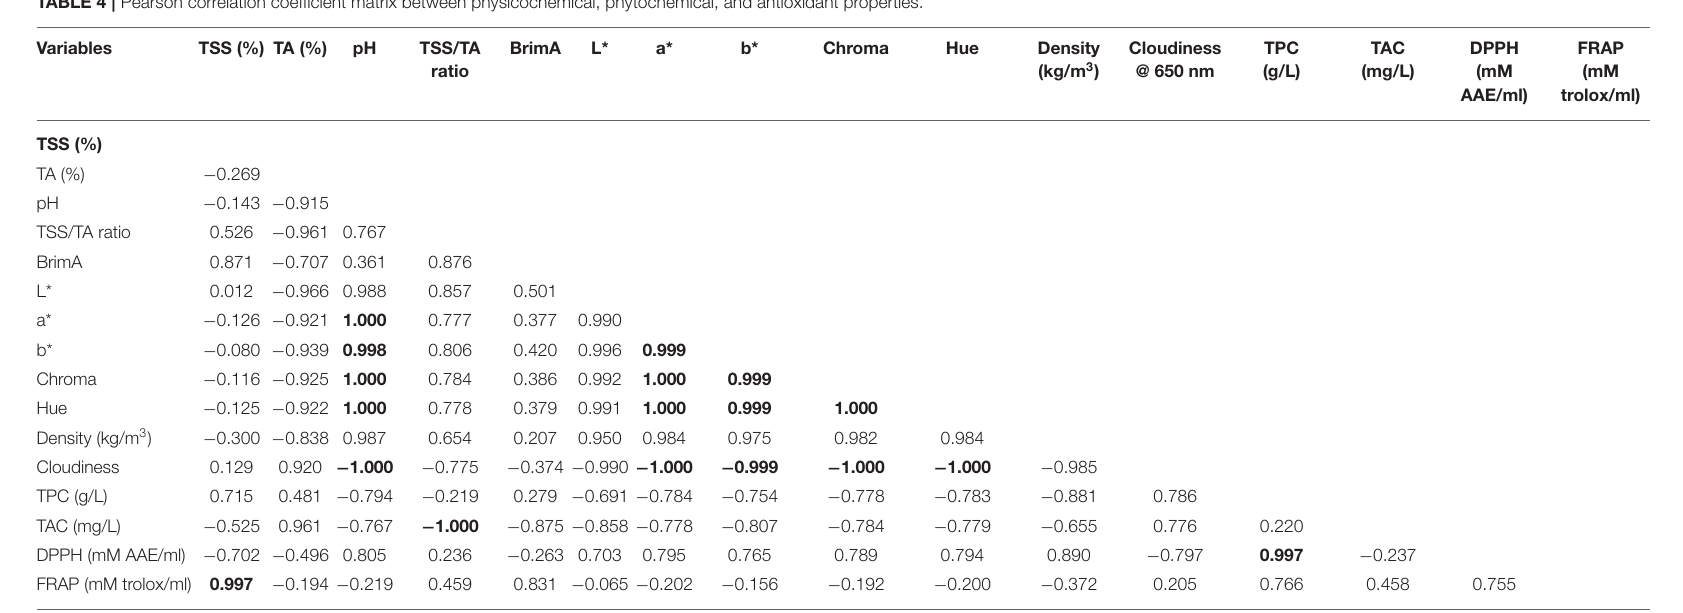
Relationships with correlation coefficients > 0.5 are presented. Correlation values in bold are significant at p < 0.05. TSS, total soluble solids; TA, titratable acidity; TPC, total phenolic content; TAC, total anthocyanin content; DPPH, 2,2-diphenyl-l-picrylhydrazyl; FRAP, ferric ion reducing antioxidant